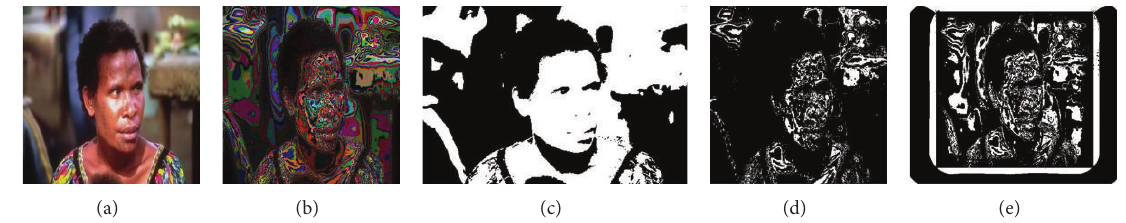
Figure 3: (a) Original image, (b) image of bit plane 5, (c) binarization of original image using mean threshold, (d) binarization of bit plane 5 with mean threshold, and (e) binarization of bit plane 5 with Niblack’s method of local threshold.